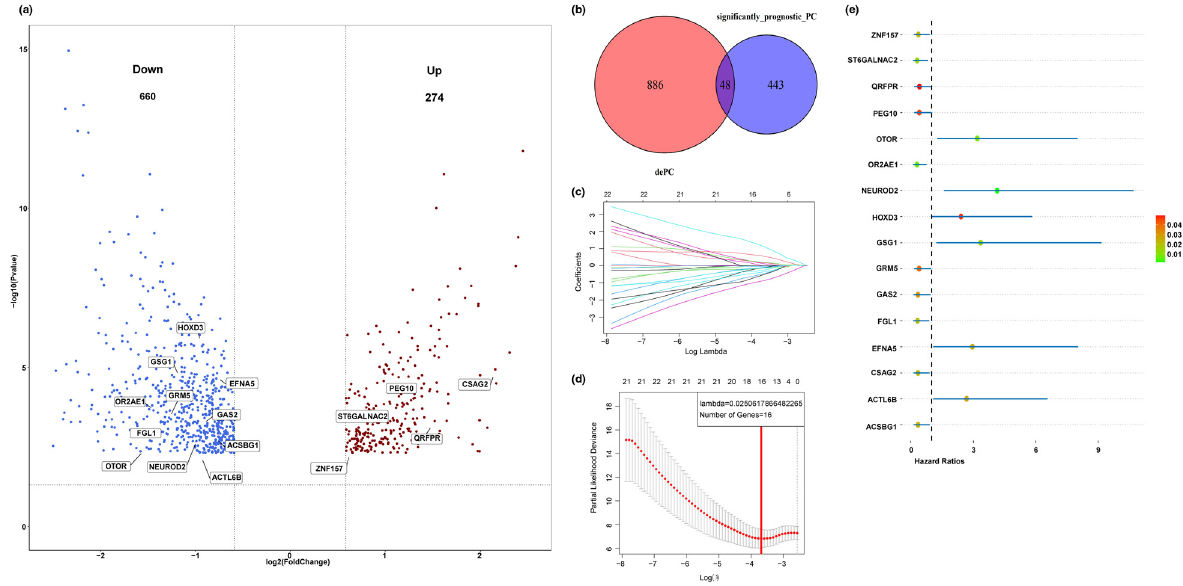
Figure 1: Identi fi cation of prognostic HRD - associated genes and model construction in the TCGA – TNBC cohort. ( a ) Volcano plot of DEGs between high - HRD and low - HRD groups. ( b ) Venn plot of prognostic HRD - associated genes. The red circle represents the DEGs and the blue circle represents the prognostic genes in TNBC. ( c ) The LASSO coe ffi cient pro fi le of 48 prognostic HRD - associated genes and perpendicular imaginary lines were drawn at the value chosen by 10 - fold cross - validation. ( d ) The tuning parameters ( log l ) of OS - related proteins were selected to cross - verify the error curve. According to the minimal criterion and 1 - se criterion, perpendicular imaginary lines were drawn at the optimal value. ( e ) Multivariate analysis of 16 selected genes in the TCGA – TNBC